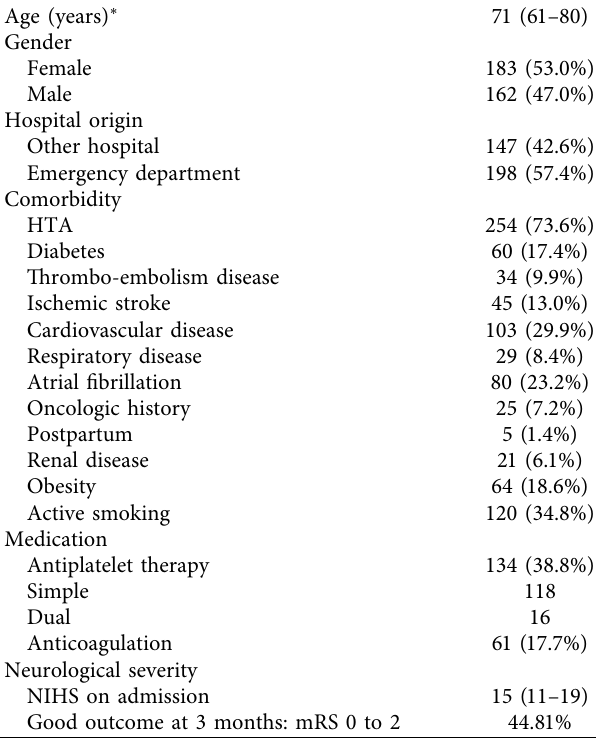
Table 1: Patients characteristics ( N � 345).